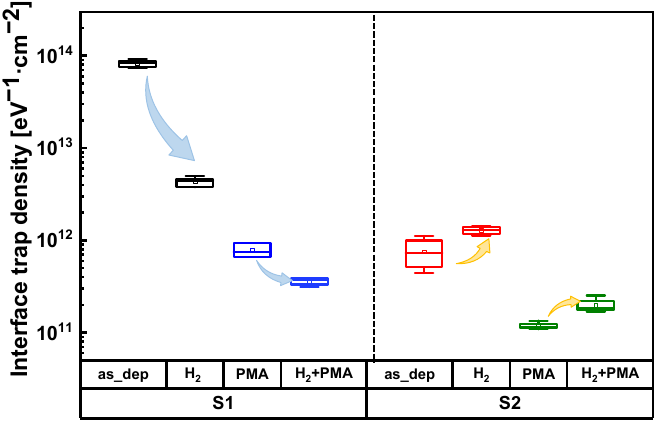
Figure 8. Interface trap density (D it ) of Al 2 O 3 samples under deposition conditions; O 2 plasma exposure time: 3 ( left side) and 7 s ( right side) and posttreatment conditions: H 2 plasma treatment and post-metallization annealing (PMA).